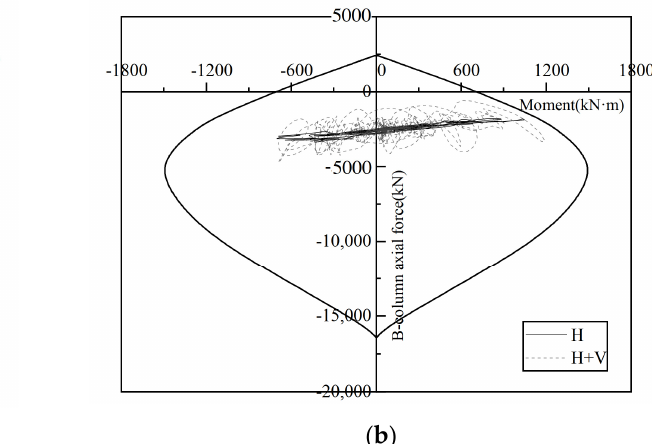
Figure 7. A − column and B − column axial force ‐ bending moment curve under two conditions of Yangbi ground motion. ( a ) A ‐ column; ( b ) B ‐ column.